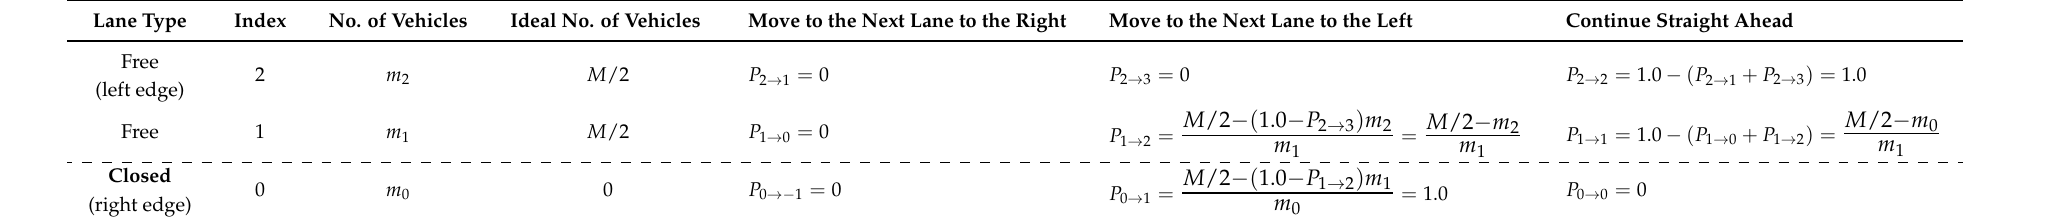
Table 2. Movement probabilities in three lanes when lane 0 is